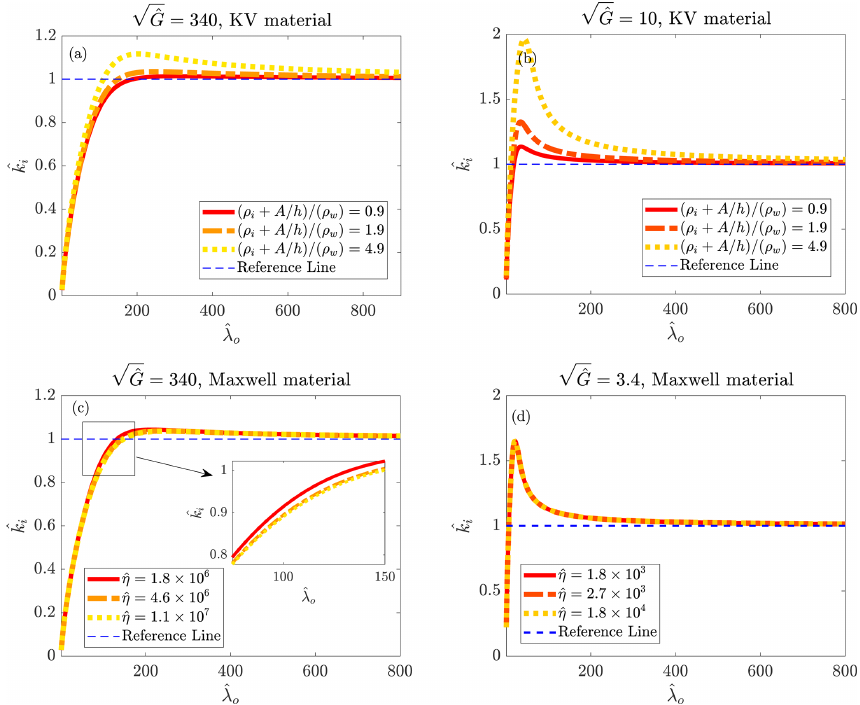
Figure 5. Effects of the added mass force (a, b) and the dynamic viscosity (c, d) on the dispersion curves of waves propagating in an ice